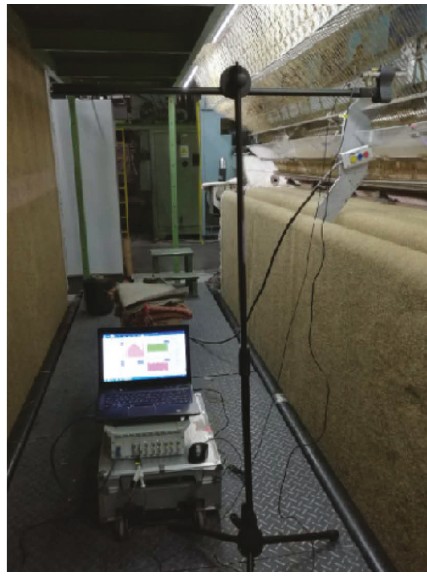
Figure 10: Noise acquisition arrangement.